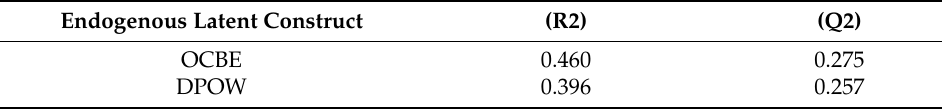
Table 4. Coefficient of determination (R2) and (Q2) of the